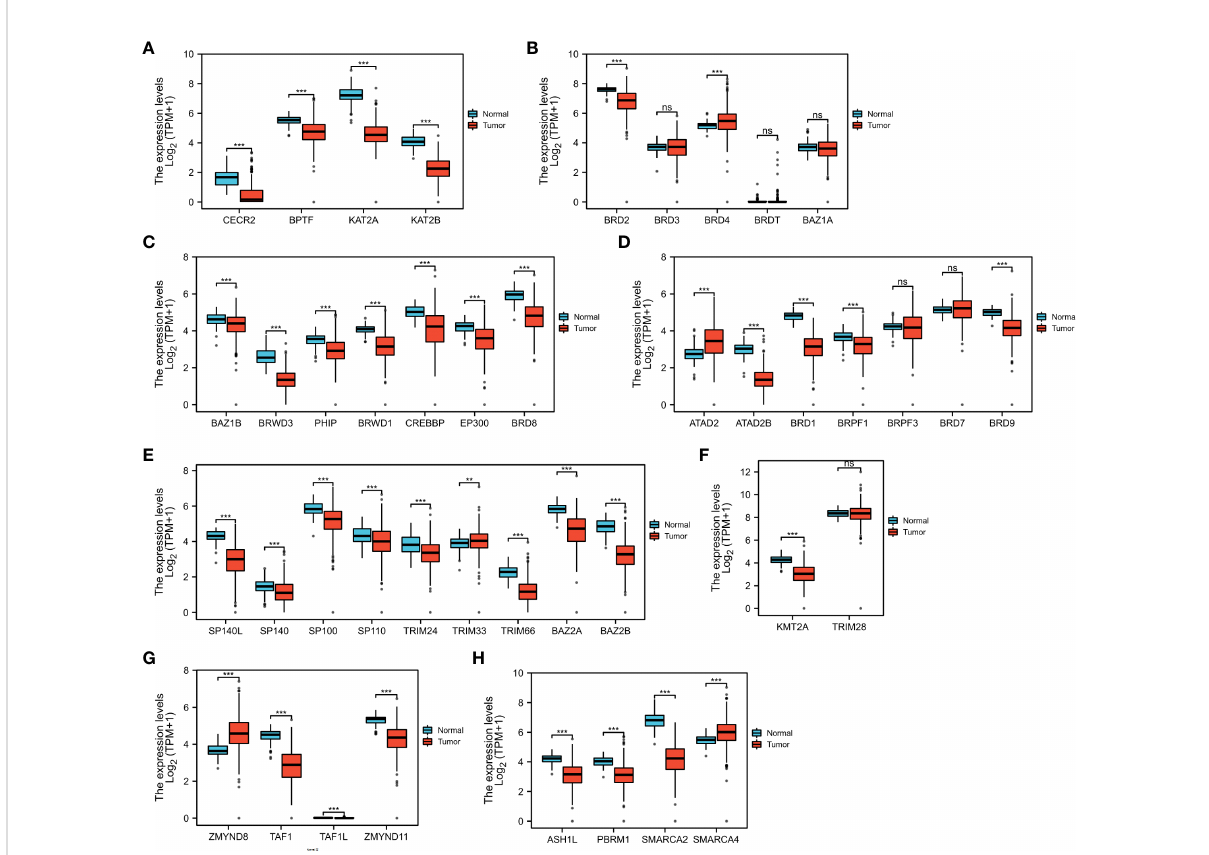
FIGURE 2 BRD mRNA levels in the OSC. The mRNA levels of BRD subfamilies I (A) /II (B) /III (C) /IV (D) /V (E) /VI (F) /VII (G) /VIII (H) in OSC samples and normal ovary samples based on TCGA and GETx databases. ns > 0.05; **p < 0.01; ***p <